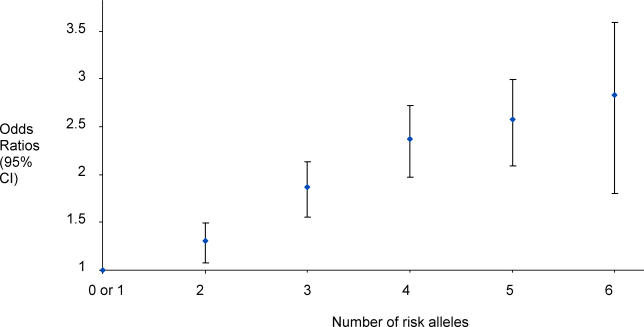
ORs and 95% CIs for Participants Carrying Increasing Numbers of Risk AllelesThe reference group is individuals with zero or one risk allele.